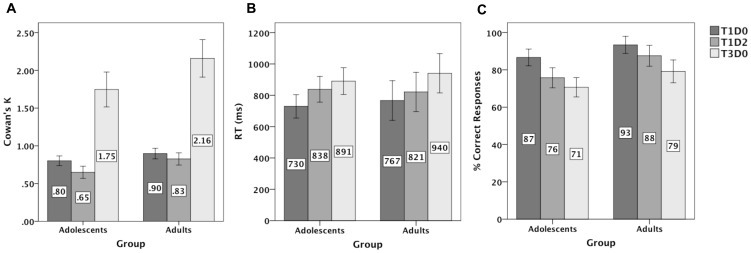
Behavioral data from the VSWM change detection task.Bar graphs of (A) Cowan's K, (B) average reaction times (in ms), and (C) percentage of correct responses for adolescents and adults in T1D0 (one target), T1D2 (one target, two distracters) and T3D0 (three targets) conditions. Error bars indicate 95% confidence intervals.